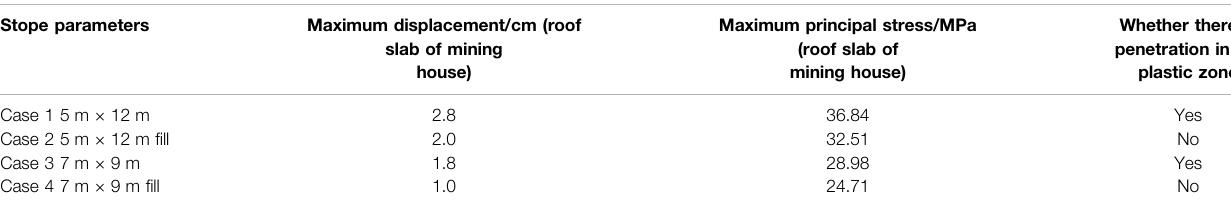
TABLE 3 | Displacement, stress and plastic zone parameters of each project.